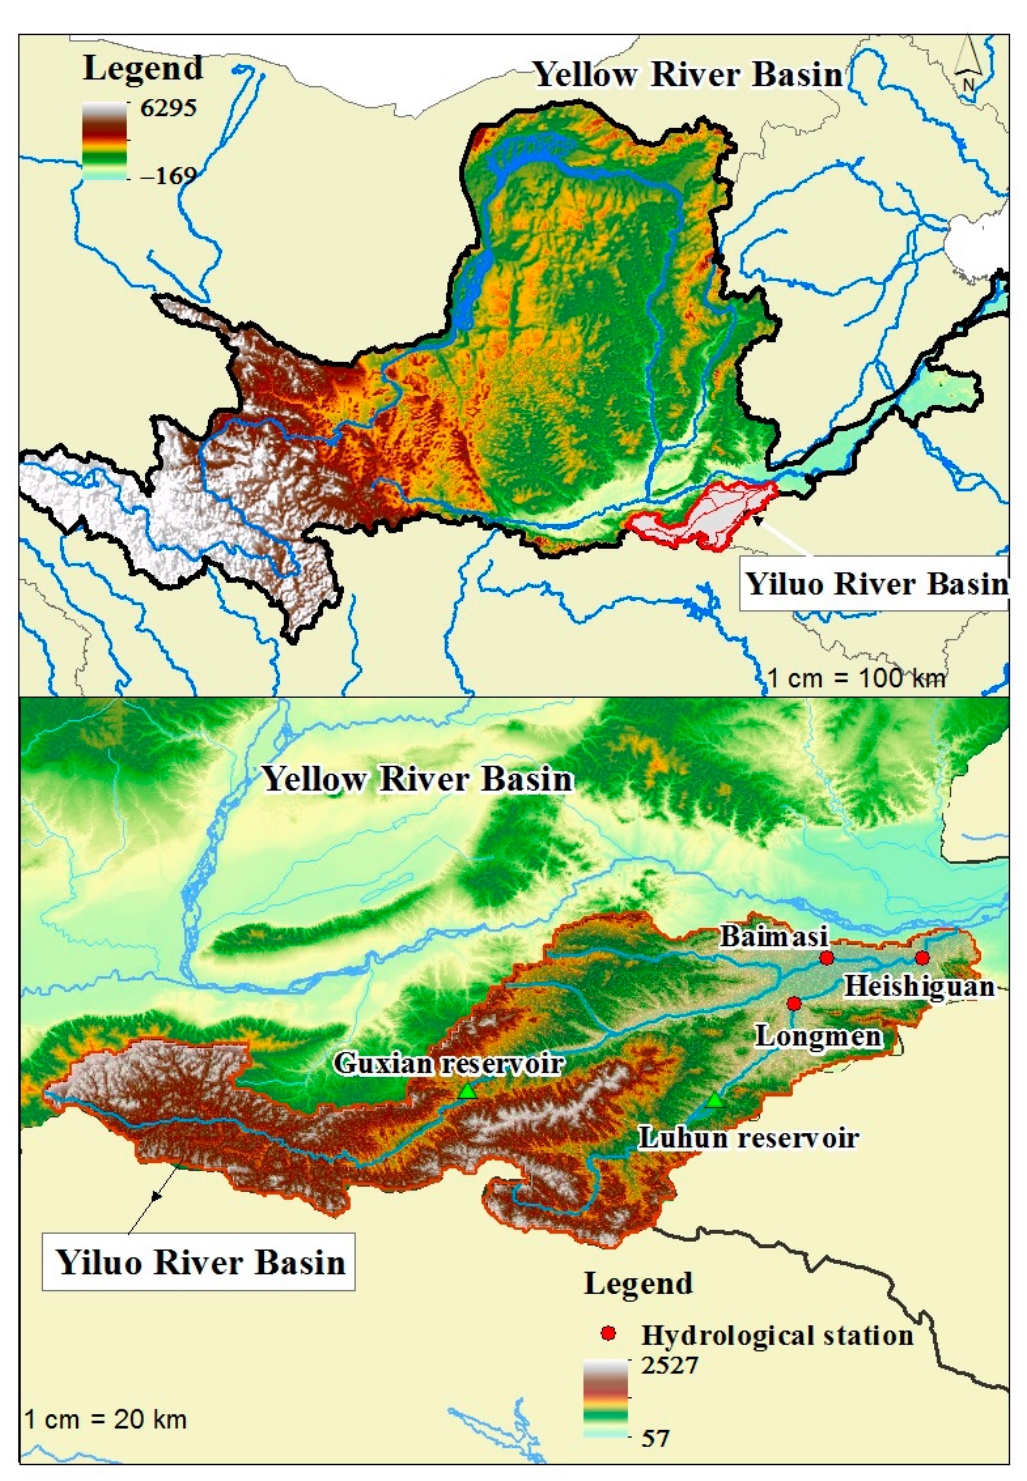
Figure 1. Location of study area and gauging stations.